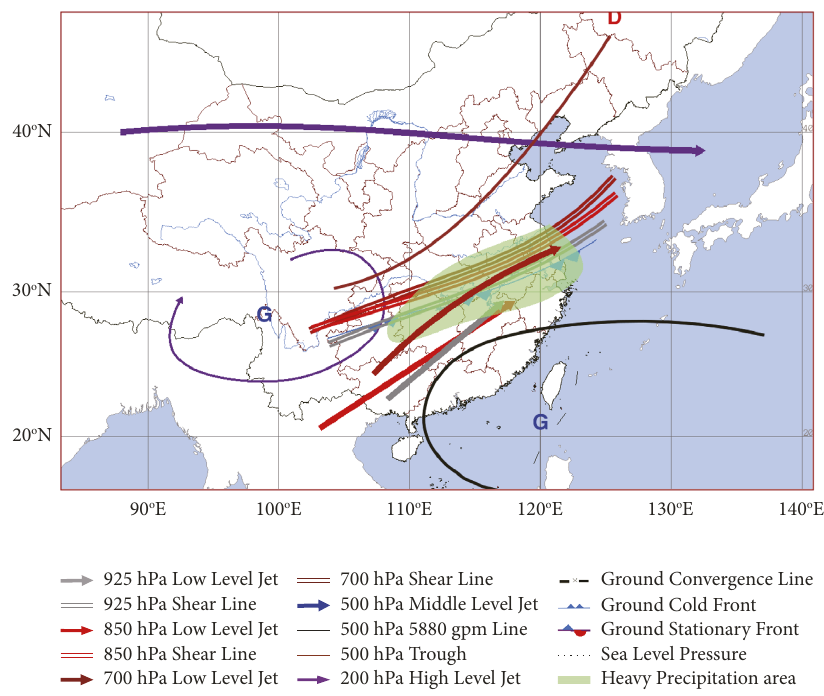
Figure 4: Conceptual model of the Northeast Cold Vortex pattern